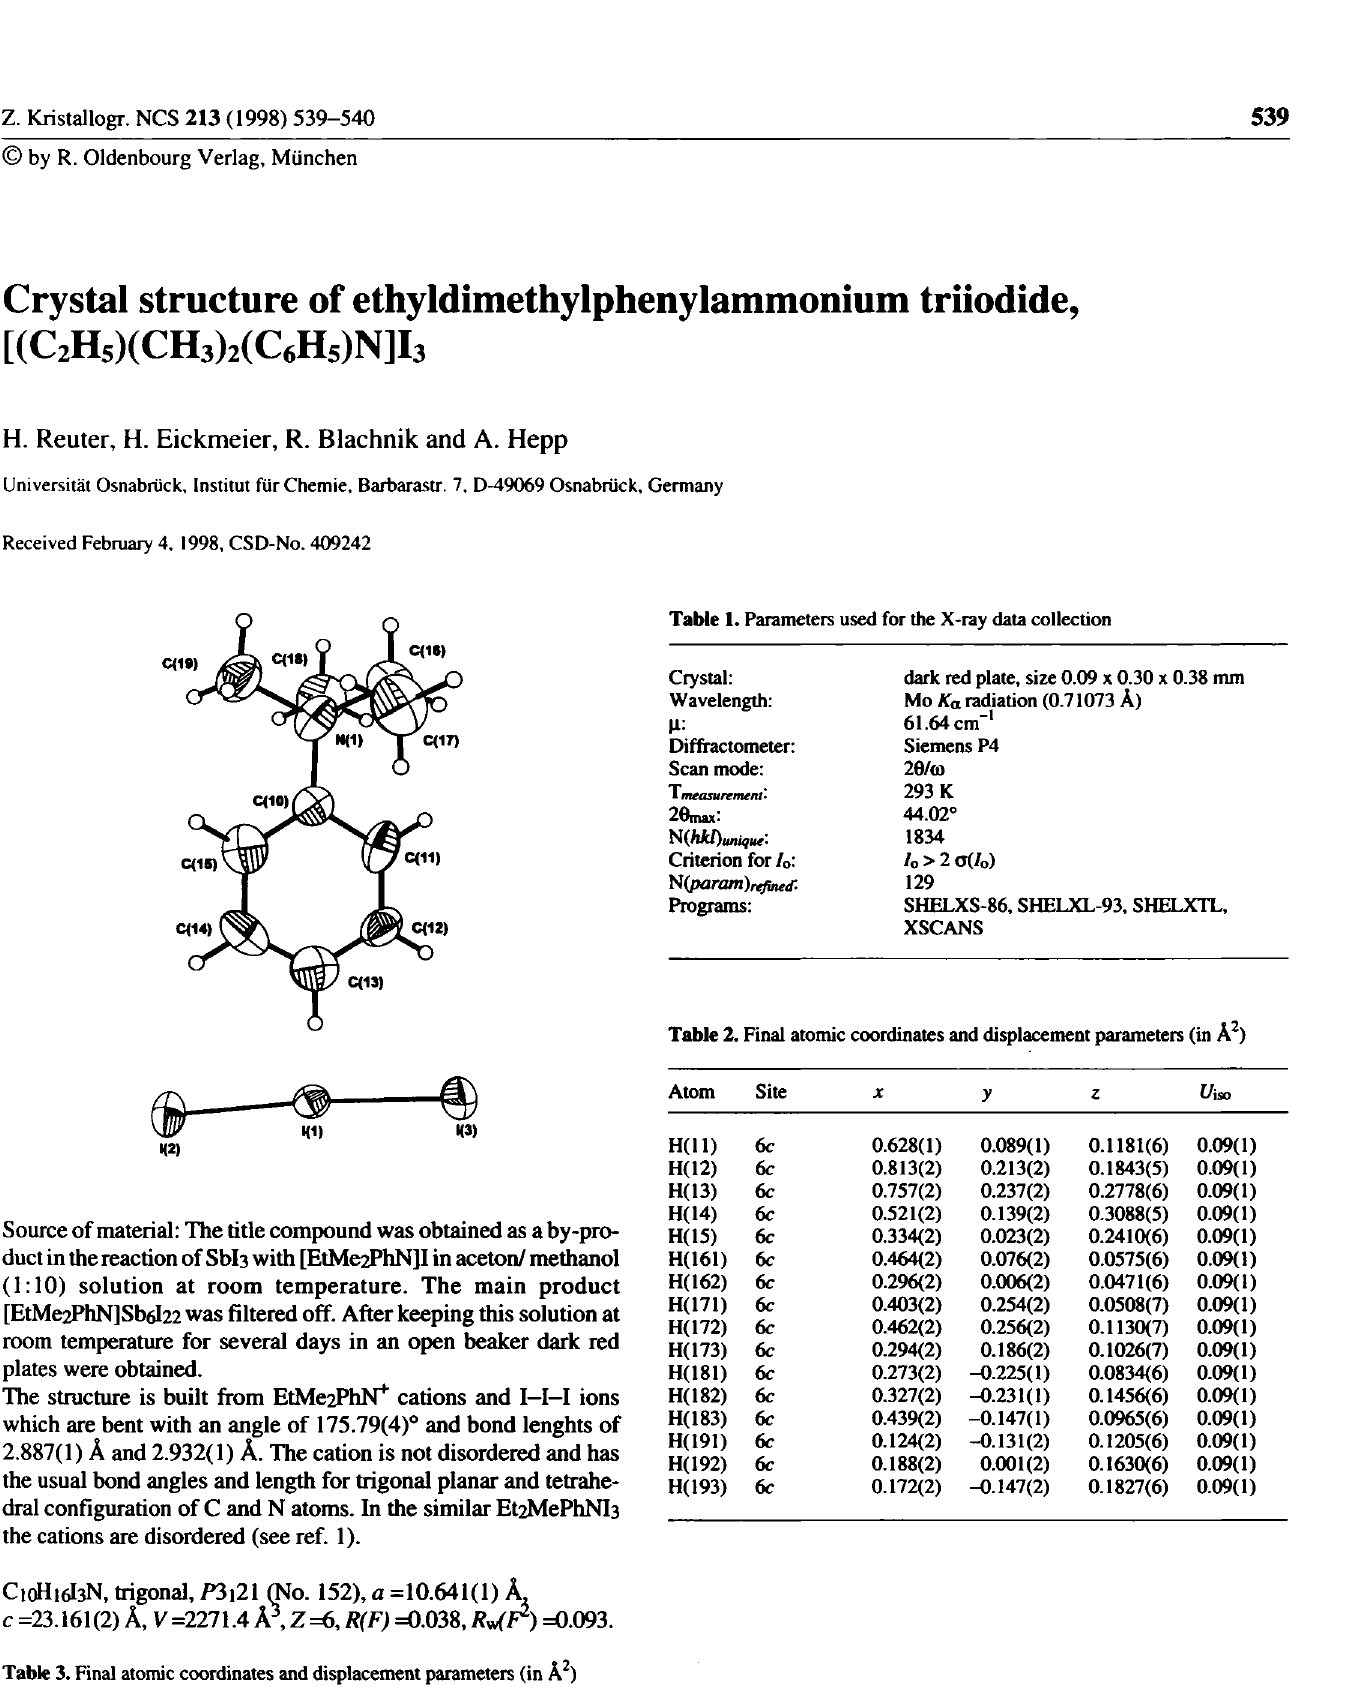
Table 3. Final atomic coordinates and displacement parameters (in Â^)